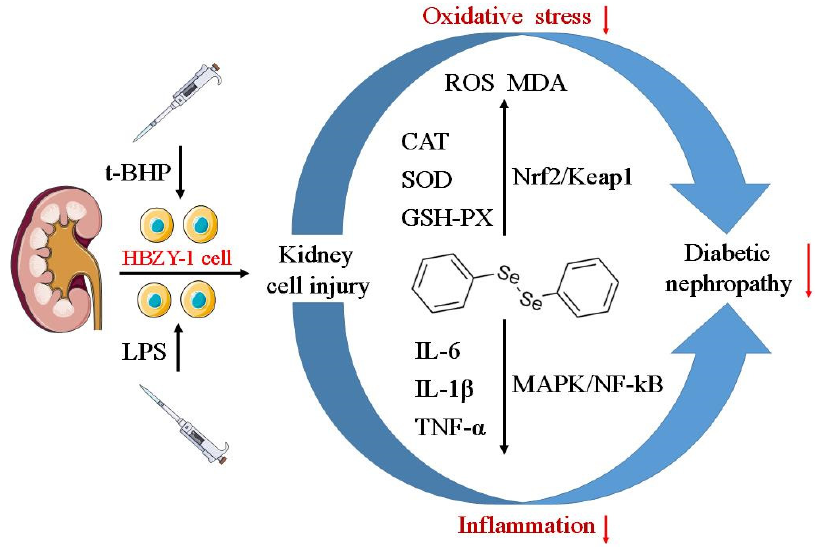
Figure 7. Schematic representation indicating the potential mechanism by which diphenyl diselenide exerts protective effects on t-BHP-induced oxidative stress and LPS-induced inflammation in HBZY-1 cells.